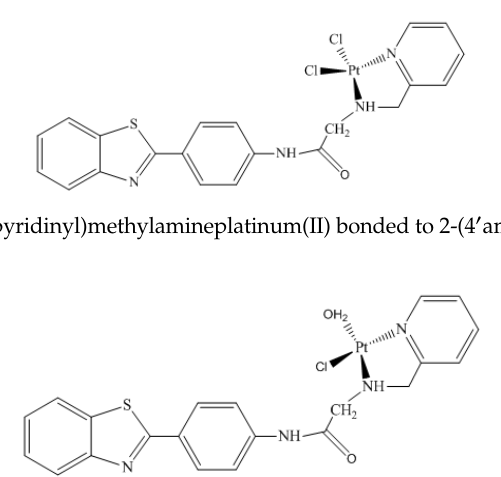
Figure 2. Monoaquated complex: Monoaquamonochloro(2’pyridinyl)methylamineplatinum(II) ion bonded to 2-(4’aminophenyl)benzothiazole derivative (Complex 2).